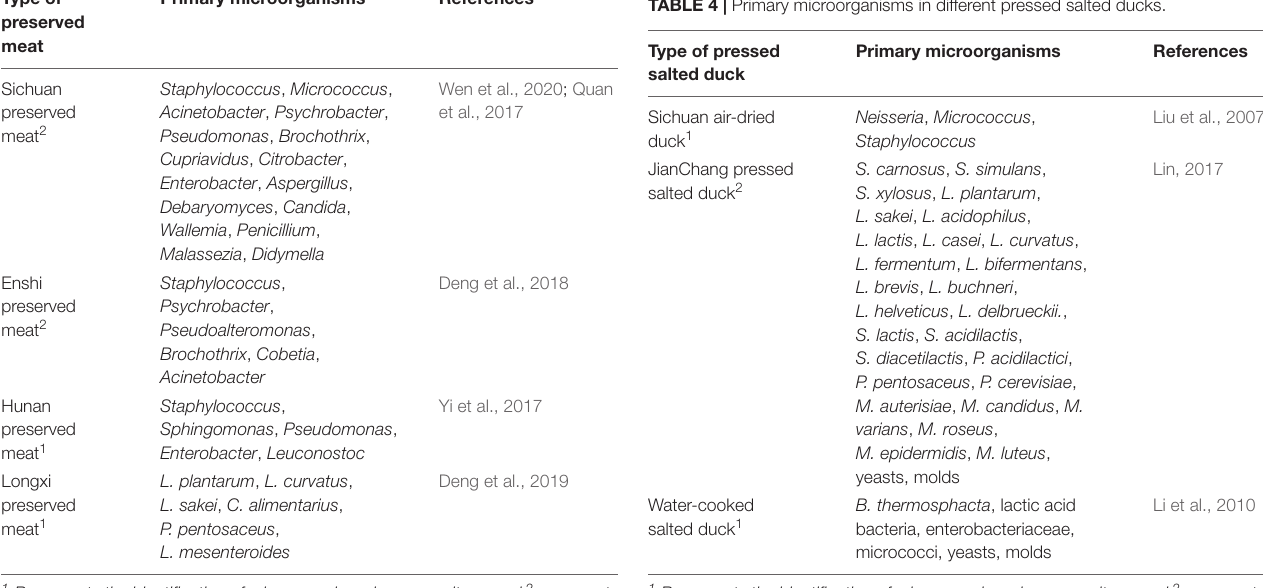
TABLE 4 | Primary microorganisms in different pressed salted